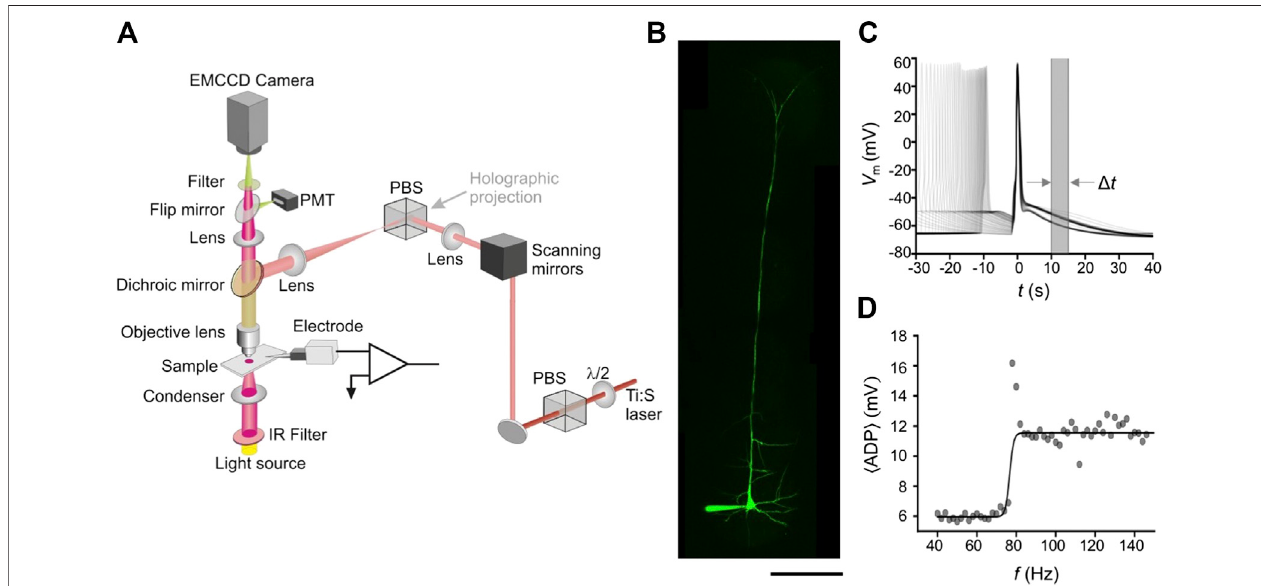
FIGURE 3 | Experimental setup and electrophysiological recordings: (A) Schematic of our custom-built two-photon microscope used for laser dendrotomy. Different modalities are merged using a polarizing beam splitter (PBS), while the emitted fl uorescence is acquired via a photomultiplier tube (PMT). (B) A fl attened image stack of an L5PN intracellularly loaded with Alexa Fluor 488 dye. (C) The membrane potential recorded from the soma following a two-AP train with frequencies from 40 to 150 Hz aligned to the second AP (D) The frequency response of the ADP from the recordings in (C) . Scale bar in (B) is 50 μ